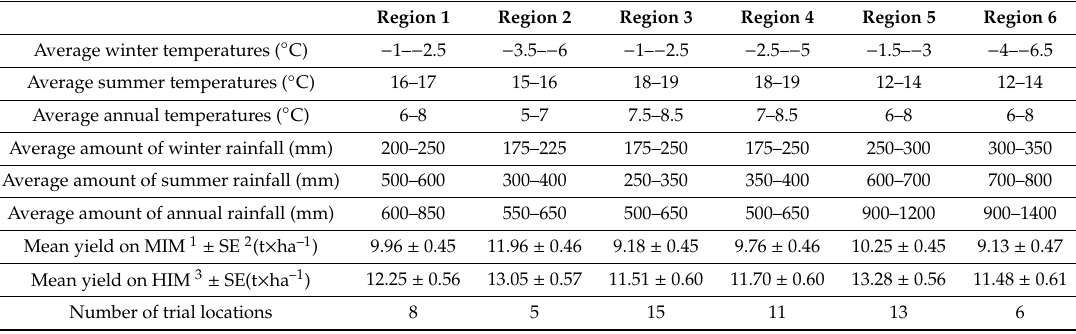
Table 1. Characteristics of the regions in Poland. The average temperatures and amount of rainfall were presented as ranges based on long-term data from meteorological stations in a region.